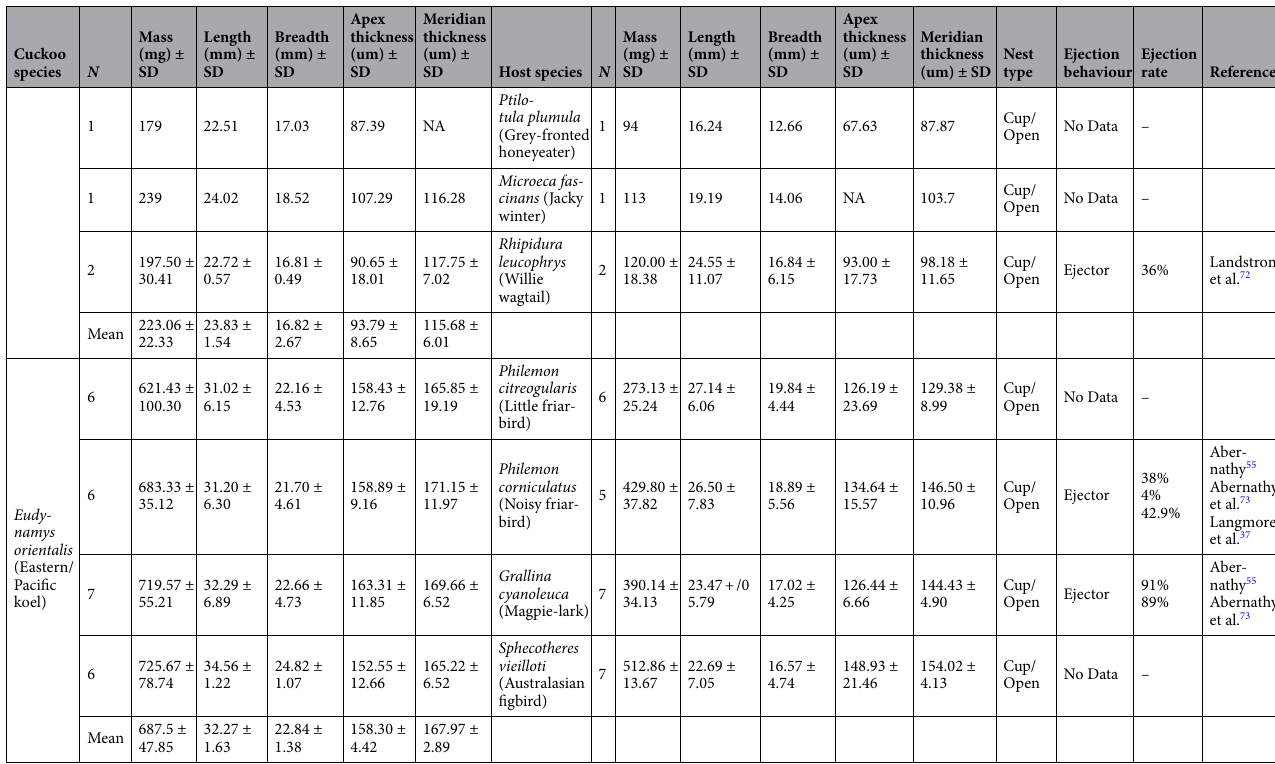
Table 1. Characteristics of Australian cuckoo eggs and the eggs of their hosts used in this study. Summary statistics for morphological egg measurements, details of host species, and the rates of cuckoo egg ejection are reported for experimental, non-mimetic model eggs. *For these hosts, rates of egg ejection were unknown, but egg ejection behaviour by hosts could be inferred from quantitative analyses revealing that the cuckoo eggs are near perfect mimics of the host eggs, suggesting that the cuckoos have been subject to strong selection for egg mimicry through host egg ejection 54,72